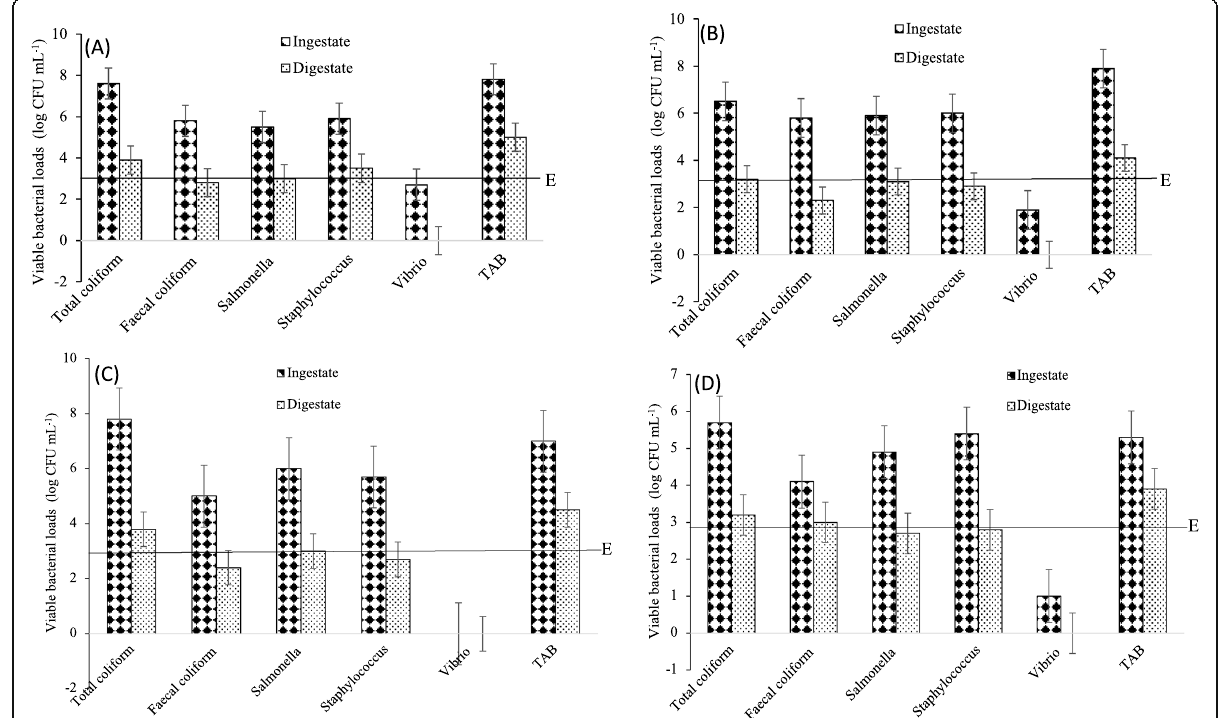
Fig. 2 Initial (ingestate) and final (digestate) viable bacterial loads (CFU mL − 1 ) during mesophilic anaerobic digestion for reactors A, B, C, and D. TAB – total anaerobic bacteria; E – EU limit for indicator bacteria in manure-based products according to animal by-product regulations [37]